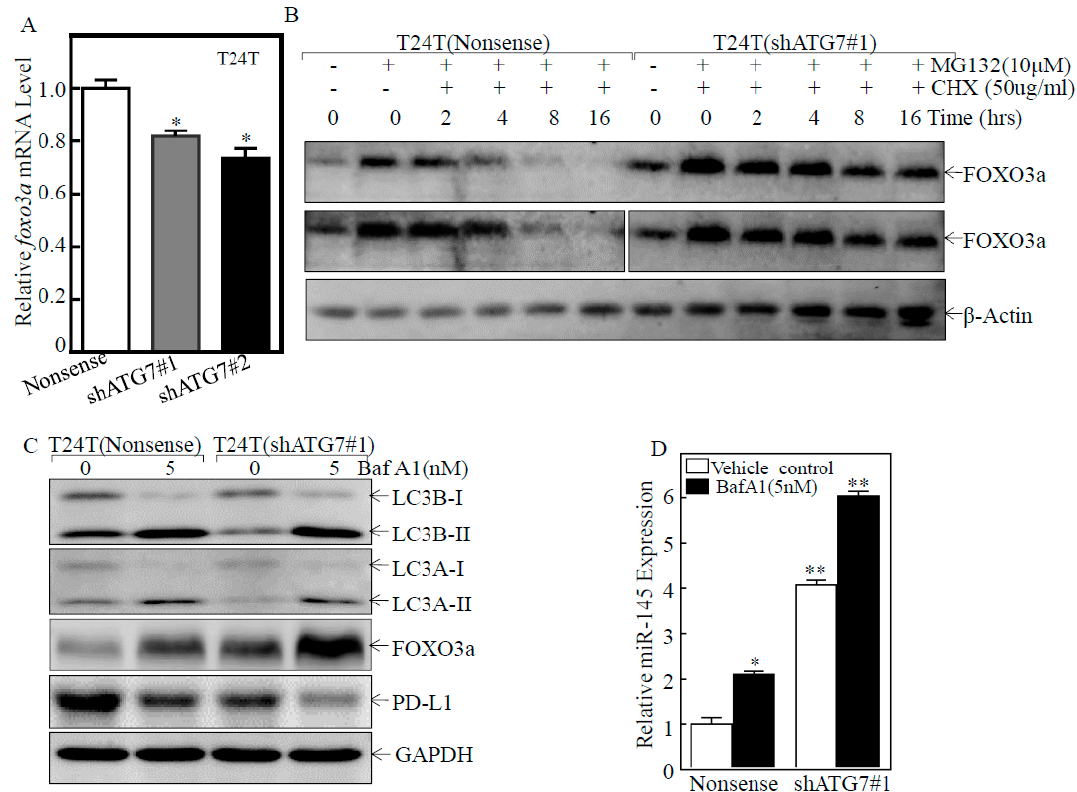
Figure 6. ATG7 promoted autophagic removal of FOXO3a protein. ( A ) Real-time PCR was used to detect foxo3a mRNA expression in the indicated cells. The asterisk (*) shows a significant inhibition in comparison to scramble nonsense transfectant (* p < 0.05). ( B ) FOXO3a protein stability was evaluated in the presence of cycloheximide (CHX) for the indicated times in T24T(shATG7#1) andT24T(shATG7#2) cells in comparison to that in T24T(nonsense) cells. ( C , D ) T24T(shATG7#1), T24T(shATG7#2), and T24T(nonsense) cells were treated with or without Baf A1 for 24 h, and the cell extracts were subjected to Western Blot to detect protein expression or Real-time PCR to determine miR-145 expression, as indicated. * p < 0.05; ** p < 0.05.